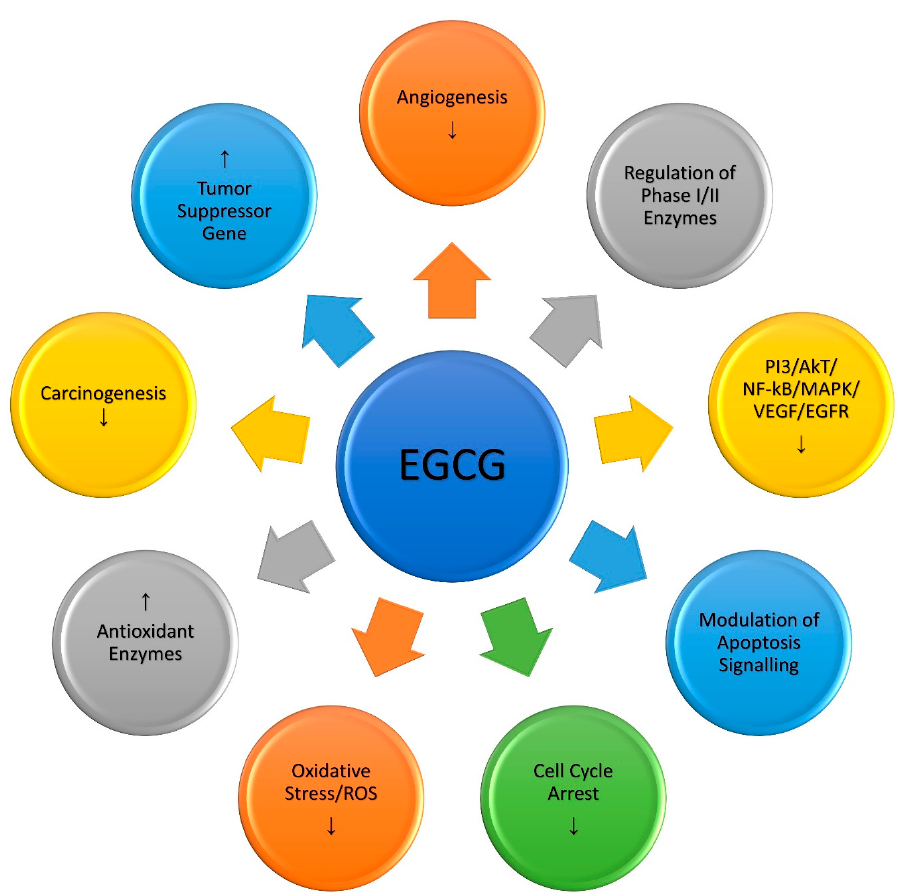
Figure 2. Molecular mechanisms involved in the anticancer activity of EGCG; ( ↑ up regulation, ↓ down regulation).